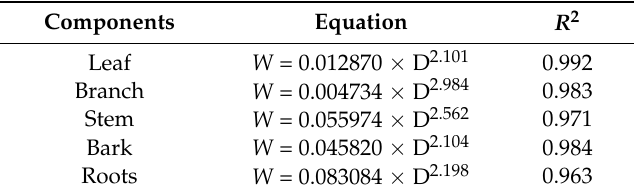
Table 1. Estimation equations for tree layer in Quercus variabilis natural